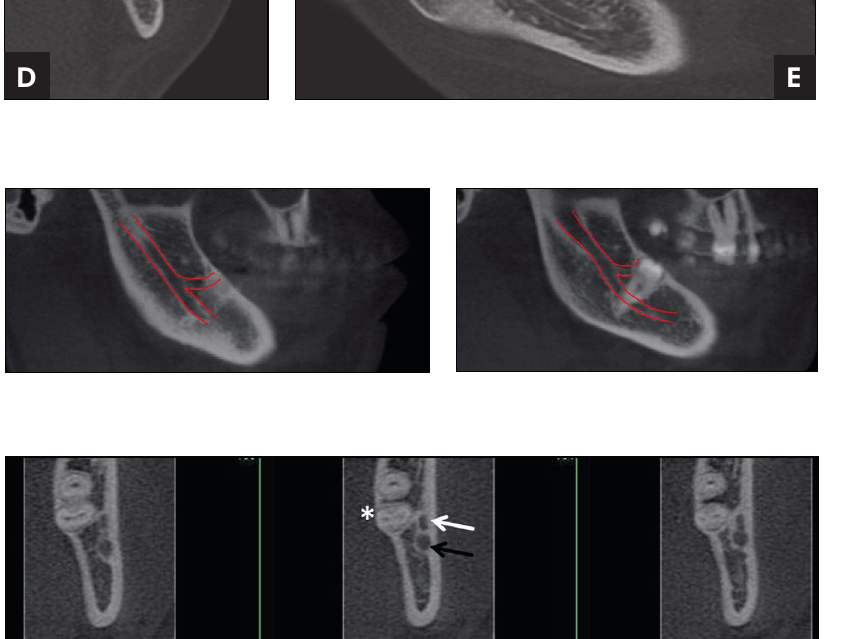
Figure 4 - Combination of the first two categories (Type 3). Right axial cut ( A ) and lateral view ( B ) of the bifurcation extending through the mandibular body (Type 2). Bilateral bifurcations in panoramic view ( C ). Left axial cut ( D ) and lateral view ( E ) of the bifurcation, limited to the rami (Type 1). The white arrows indicate the bifurcations of the mandibular canal and the black arrow indicates the mandibular canal.